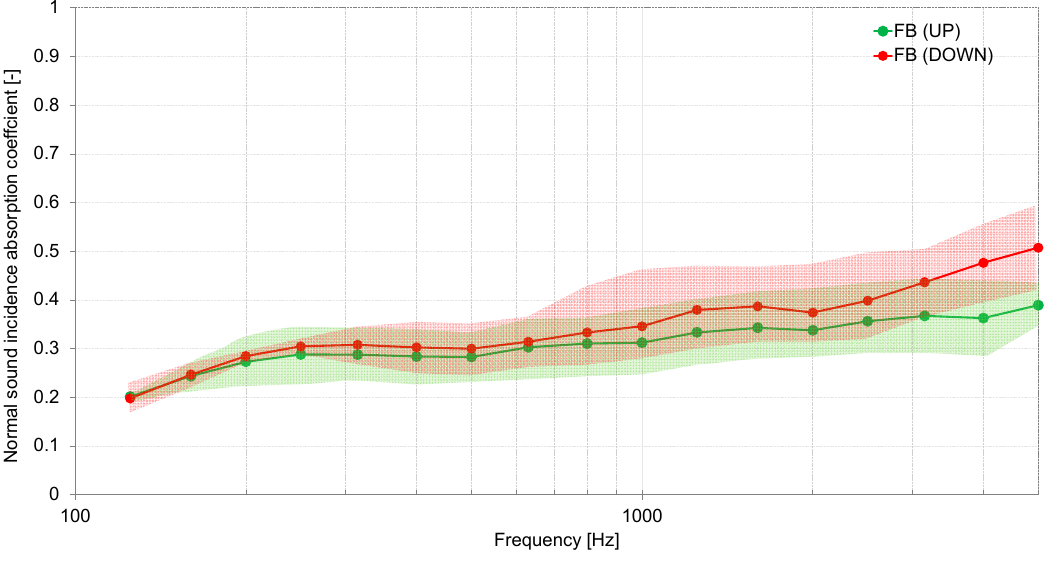
Figure 8. Normal incidence sound absorption coe ffi cients experimentally measured (FB mix).